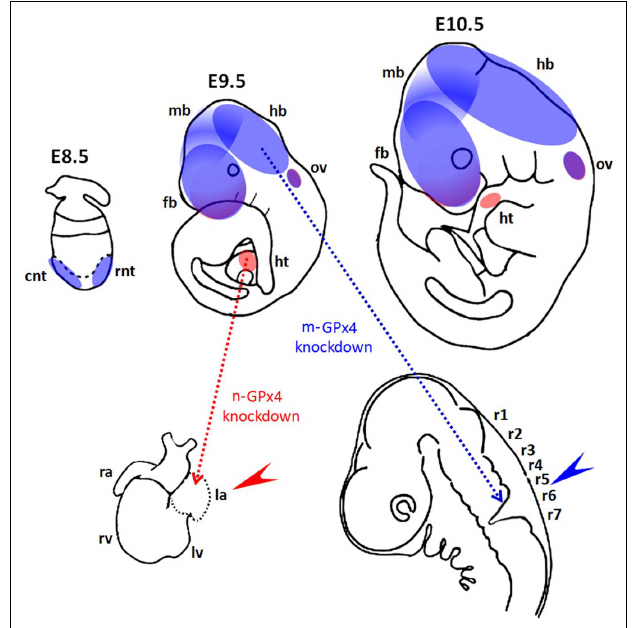
FIGURE 3 | Functional roles of GPx4 in mouse development. (Upper panel) Diagrams show spatial expression of mitochondrial GPx (m-GPx4, blue) and nuclear GPx (n-GPx4, red) in developing mouse embryos at gestational day E8.5–E10.5. Expression of m-GPx4 and n-GPx4 are overlapping in frontal forebrain (fb) and otic vesicles (ov). m-GPx4 is mainly expressed in both rostral and caudal neural tube (rnt and cnt) in early stage and at forebrain (fb), midbrain (mb), and hindbrain (hb) in later stages. n-GPx4 is expressed in the developing heart (ht). (Lower panel) Diagrams show the abnormal embryo development following isoform specific GPx4 knockdown by RNA interference in whole mouse embryo culture. m-GPx4 siRNA constructs induce minor microencephaly and abnormal hindbrain development (blue arrow) in the fifth and sixth rhombomeres (r5 and r6). n-GPx4 siRNA constructs induce growth restriction and abnormal heart formation (red arrow) of the left atrium